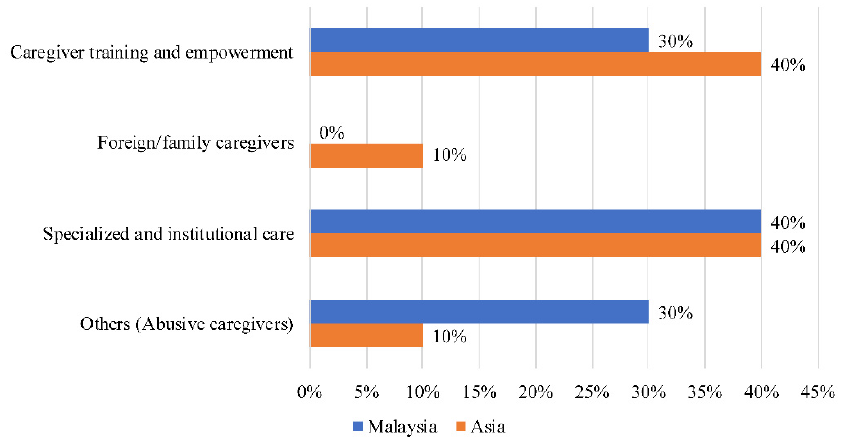
Figure 6. Societal narratives on caregivers in Malaysia.